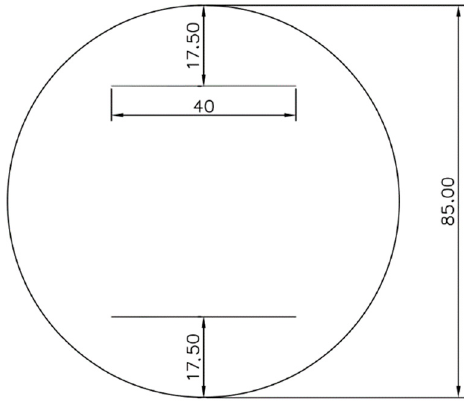
Figure 2. Position of the flat steel meshes inside the